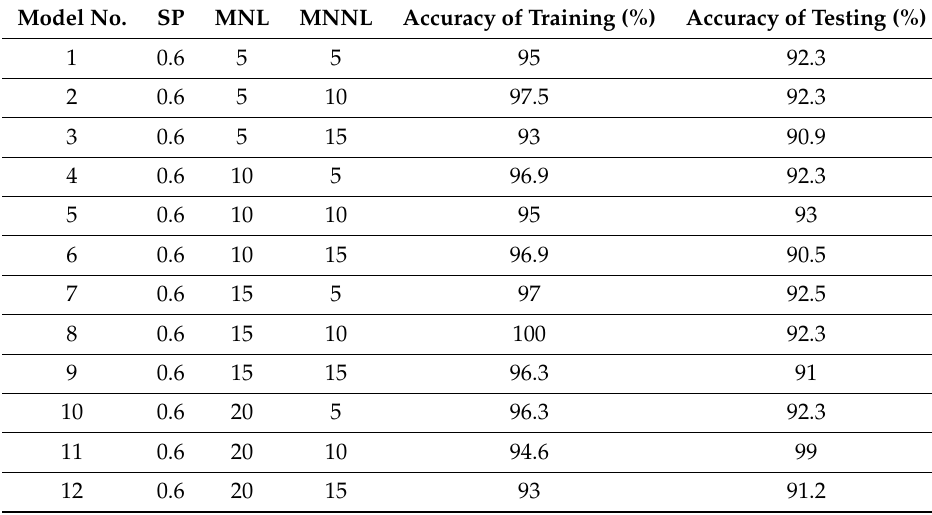
Table 2. The e ff ect of di ff erent values of two control parameters on the accuracy of training and testing datasets. Model